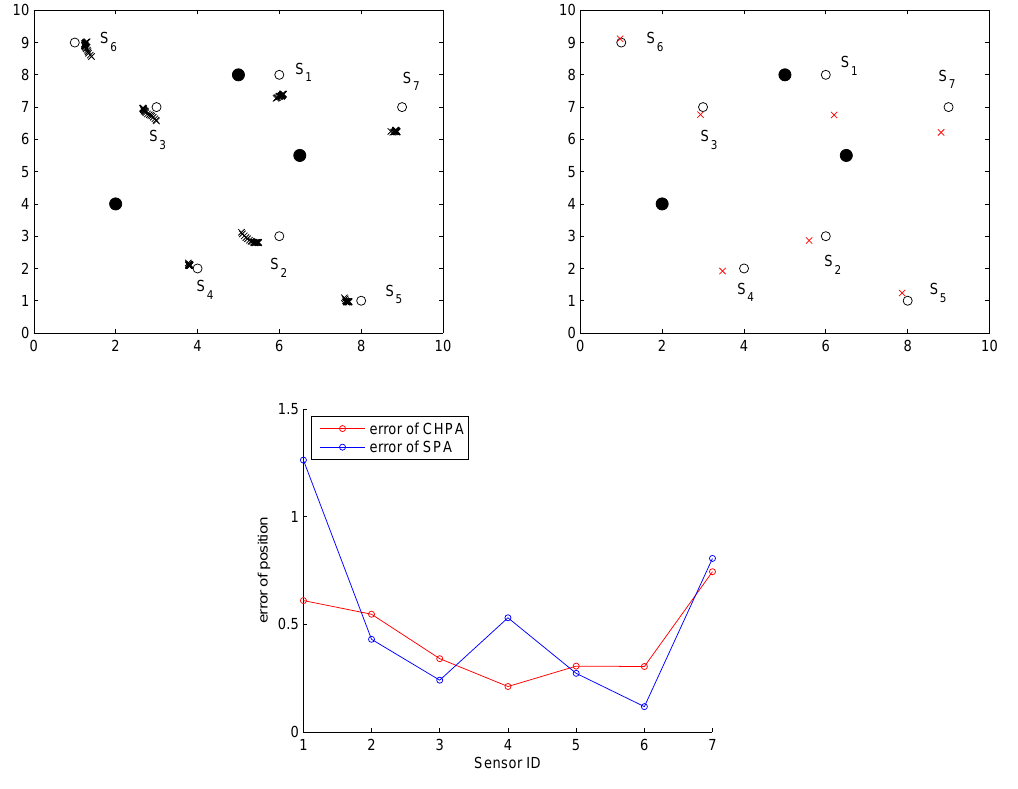
Figure 19. The average position error of each unknown sensor with the measurement noise σ 2 = 0 . 1 ; the proposed CHPA (top left); the SPA (top d